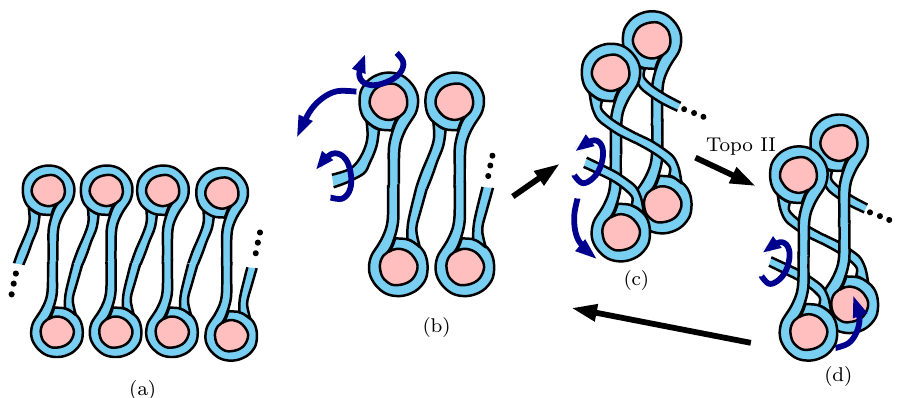
Fig. 8. Schematic diagrams showing the unknotting operation done by Topo II at crossings near the nucleosomes.